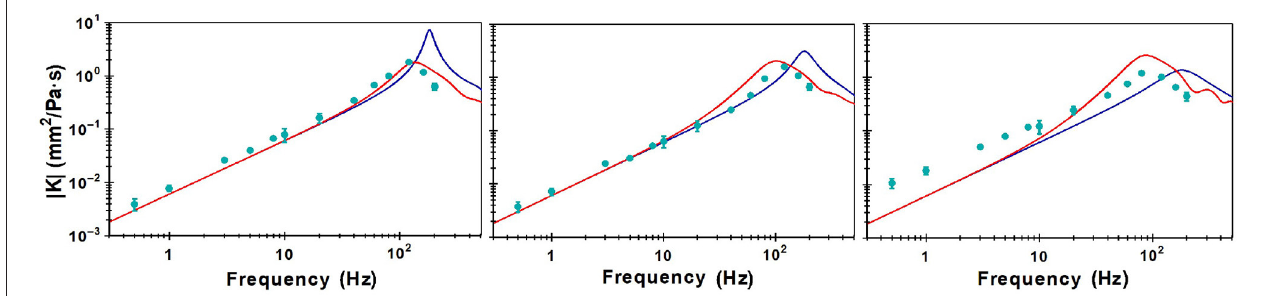
FIGURE 9 | Comparison of theoretical (red and blue lines) and experimental results (green dots) for dynamic permeability for PEO solutions at 225 Pa of: (left) PEO1 solution; (middle) PEO5 solution; (right) PEO8 solution.